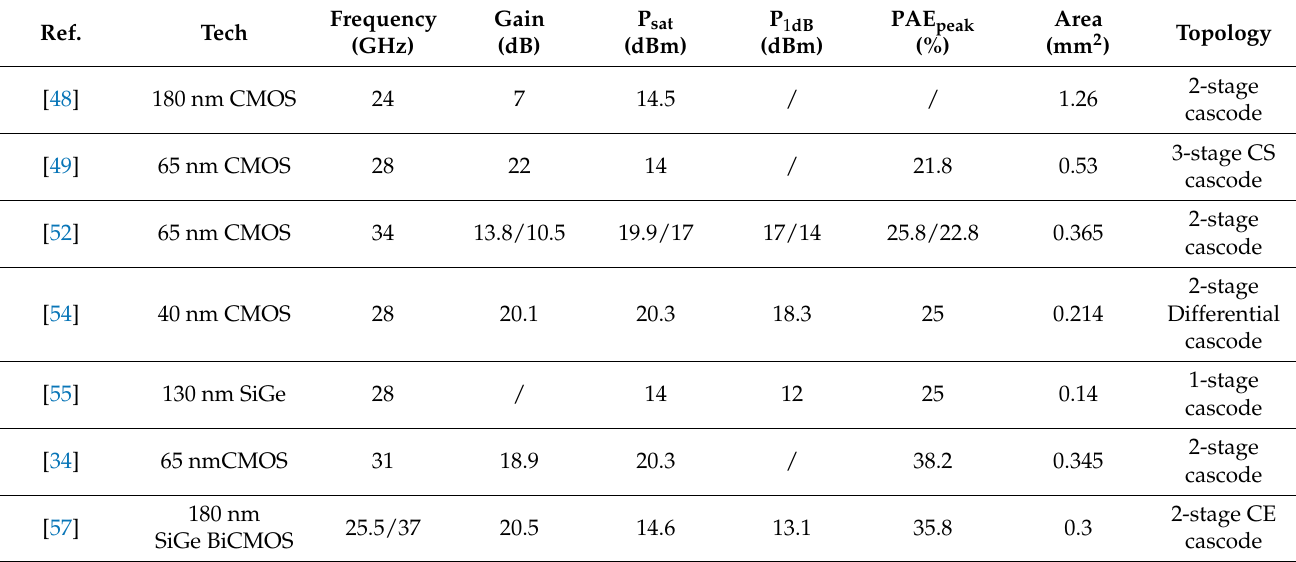
Figure 10. ( a ) The 2-stage cascode PA in 60 nm CMOS [34] ( b ) 2-stage CE cascode PA in 180 nm SiGe BiCMOS [57]. A summary comparison with cascode PA measurements is given in Table 2. Table 2. Comparison of the measurement results with the coscode